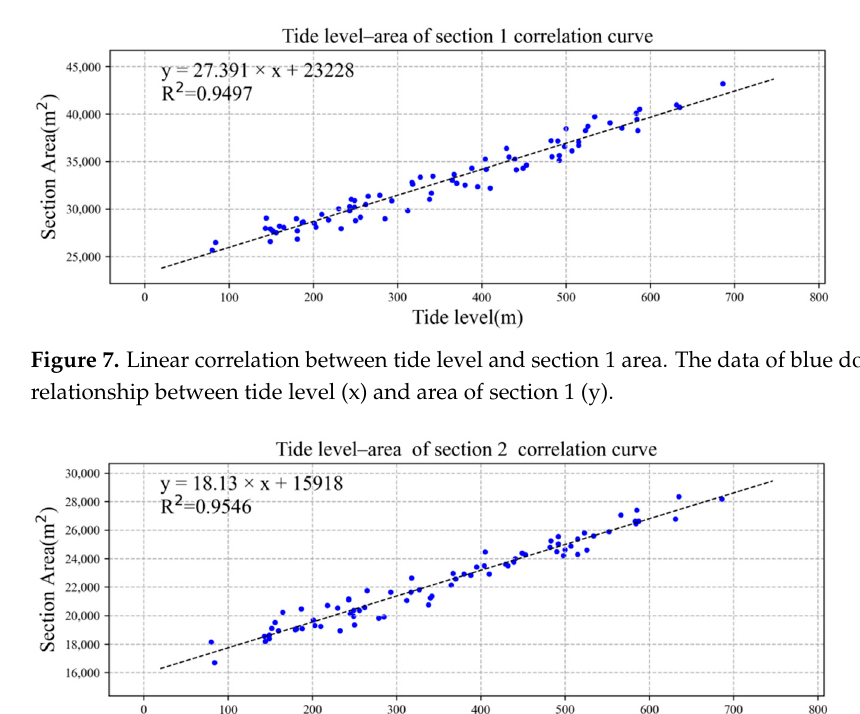
13 of 20 Figure 6. Process curve of fixed ‐ site buoy vertical average velocity and section average velocity. ( a ) Normal season spring tide average velocity & section average velocity of the fixed ‐ site, ( b ) Normal season neap tide average velocity & section average velocity of the fixed ‐ site, ( c ) Wet season spring